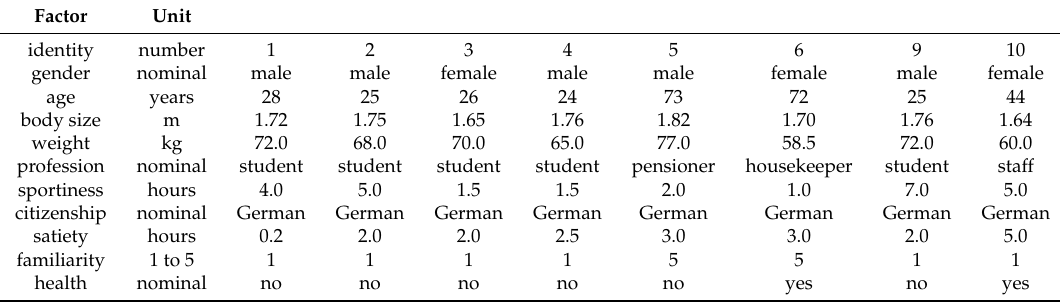
Table 1. Physical properties of the analysed participants.